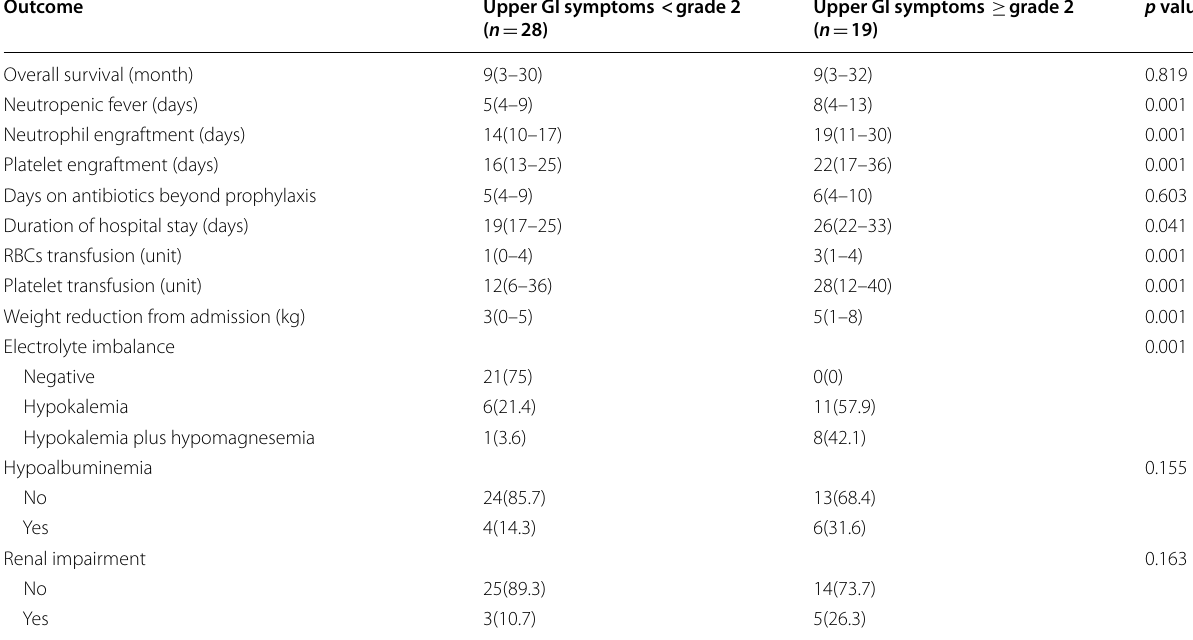
Values are expressed as median (range) and n (%)